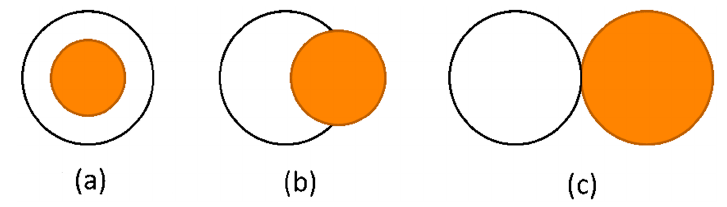
Figure 1. Morphologies of microdroplets: ( a ) Engulfing; ( b ) Partial-engulfing; ( c ) Non-engulfing.